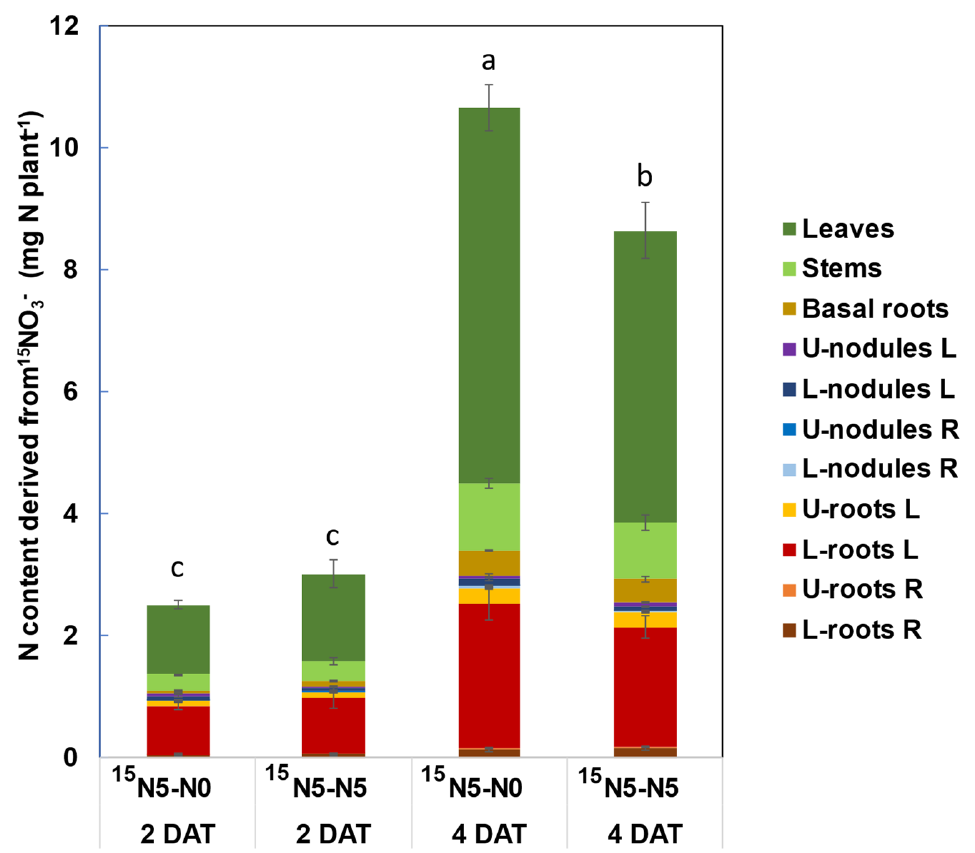
Figure 3. Nitrogen content in each part of soybean plants treated with 15 NO 3 − after 2 and 4 days of treatment. The experimental setting is described in the legend of Figure 2. Different letters indicate a significant difference ( p < 0.5) based on Tukey’s test. N = (4). Average ± SE.